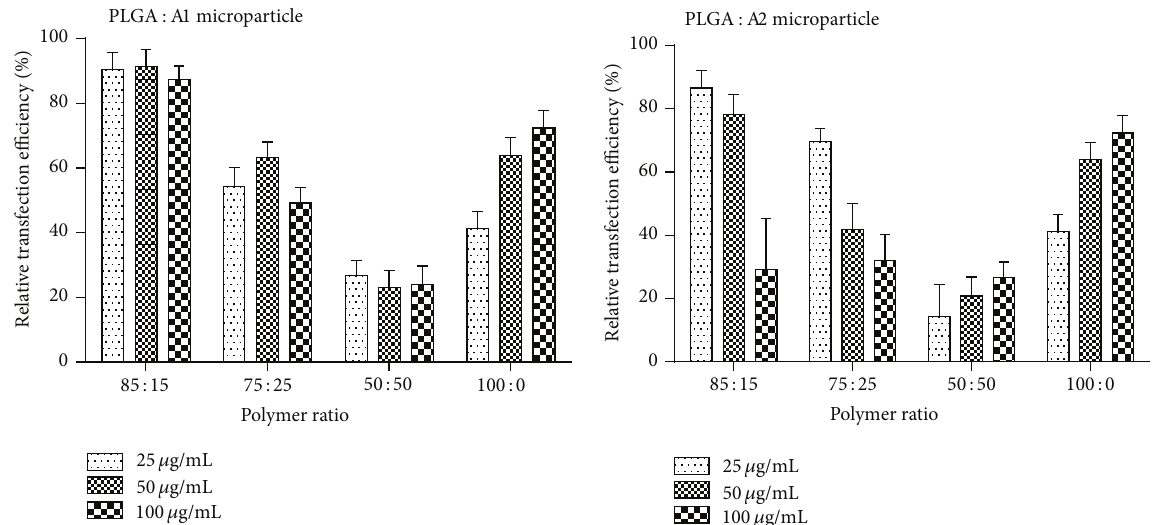
Figure 5: Relative transfection efficiency of microparticles by bright glow luciferase